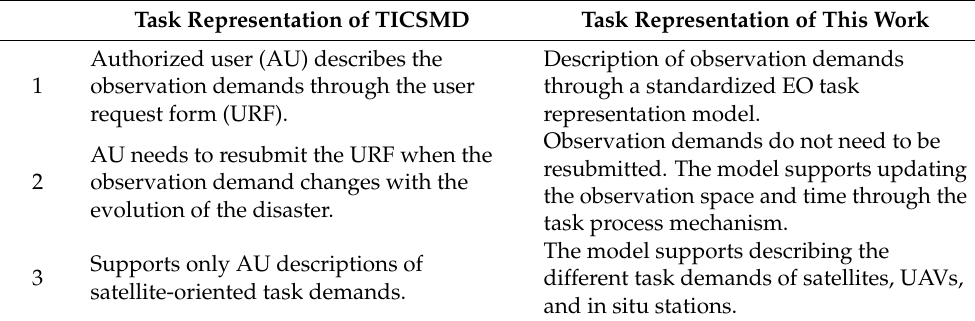
Table 1. Comparison of task representation of TICSMD and this work. Task Representation of TICSMD Task Representation of This